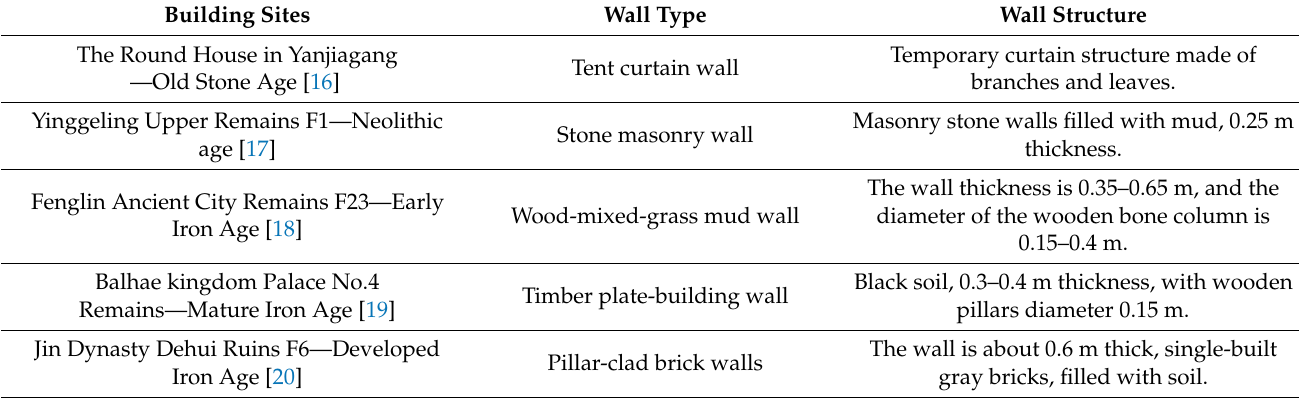
Table 1. The types, examples, and material structures of exterior walls in Amur river basin